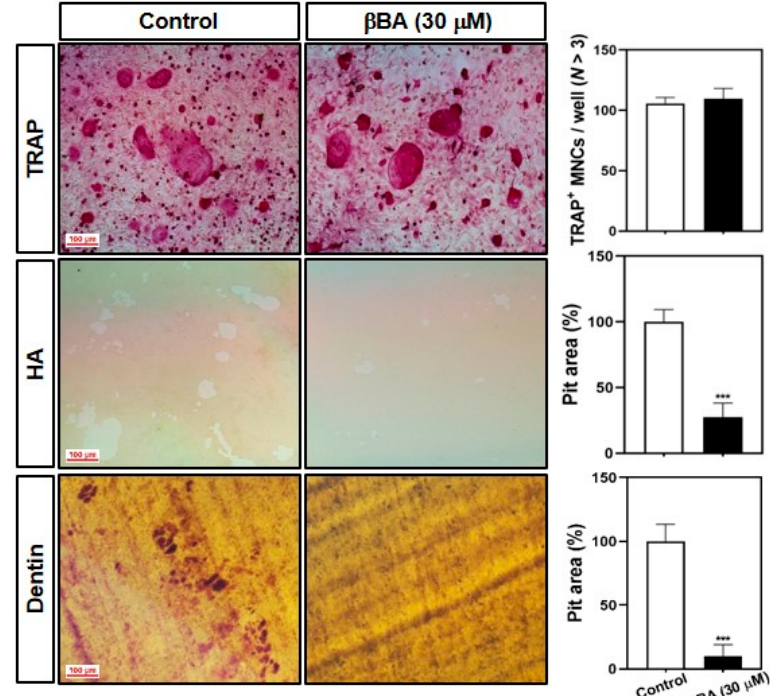
Figure 2. β -boswellic acid ( β BA) suppresses the bone-resorbing activity of mature osteoclasts. Mature osteoclasts were prepared with co-cultured osteoblasts and bone marrow cells on a collagen matrix plate. Mature osteoclasts were cultured in a 48-well plate for 24h, in a hydroxyapatite-coated plate (HA) for 24h, or in dentin slices for 48h with or without β BA (30 µ M). The cells attached to 48-well plates were stained with a TRAP solution (top), and the cells on HA (middle) and dentin slices (bottom) were removed with 10% bleach solution. The dentin slices were counterstained with hematoxylin solution, and the resorbed surface was photographed under a light microscope. The number of TRAP-positive multinucleated cells (TRAP + MNCs; N > 3) was counted, and the relative pit areas in the HA and dentin slices were quantified using Image-Pro Plus (Ver 4.5) software. Scale bar, 100 µ m. Data represent means ± SD (n = 3). *** p < 0.001 vs. as compared with DMSO